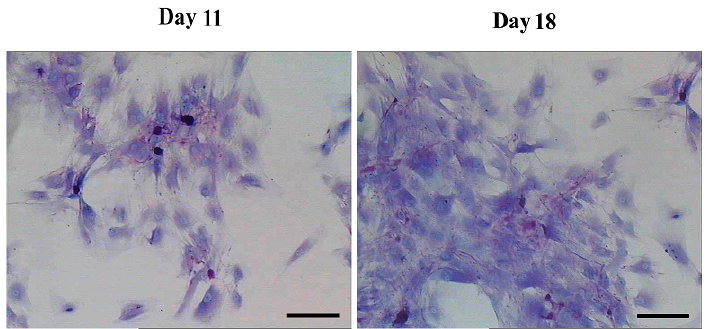
Figure 8. Functional analysis by periodic acid-Schiff (PAS) staining. PAS staining showed positive in AD-MSCs after they were exposed to hepatic differentiation medium at day 11 and day 18. Scale bars, 50 μ m. (Original magnification, ×200).